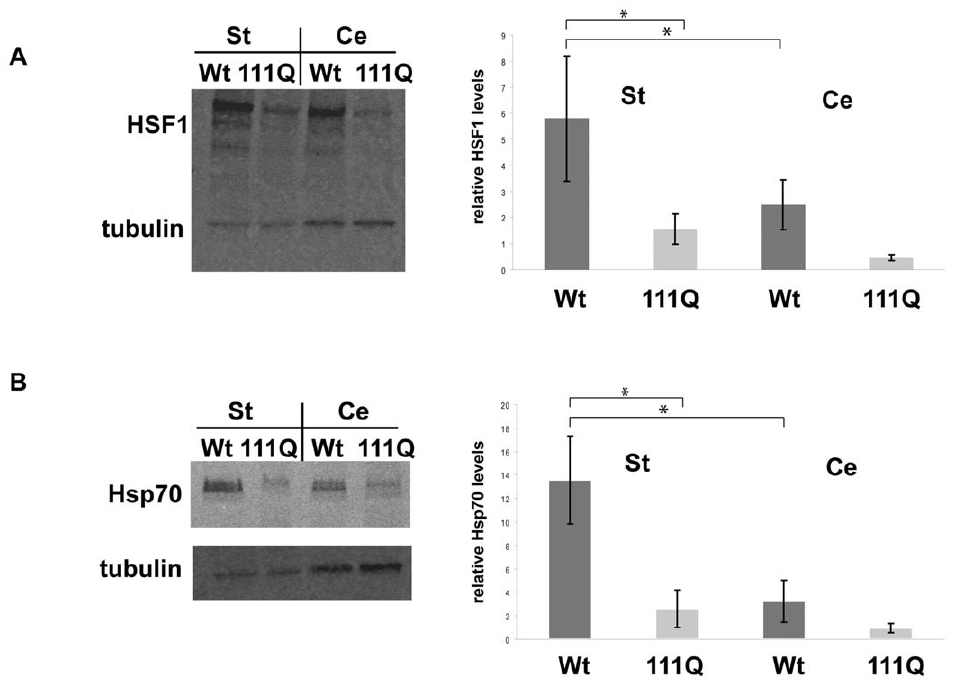
Figure 6. Reduced levels of HSF1 and Hsp70s in striata of HD knock-in mice. A ) Western blots were prepared with protein lysates from the cerebella (Cer) or striata (St) from wild-type (WT) or STHdh(Q111) knock-in mice and probed with anti-HSF1 antibodies and anti-tubulin antibodies as a loading control (left panel). Quantification of three independent Western blots. Error bars represent SDs. *p , 0.07 (two-tailed t-test). B ) Western blots were prepared with protein lysates from the cerebella (Cer) or striata (St) from wild-type (WT) or STHdh(Q111) knock-in mice and probed with anti-Hsp70 antibodies (3A3) and anti-tubulin antibodies as a loading control. Quantification of three independent Western blots. Error bars represent SDs. *p , 0.07 (two-tailed t-test).